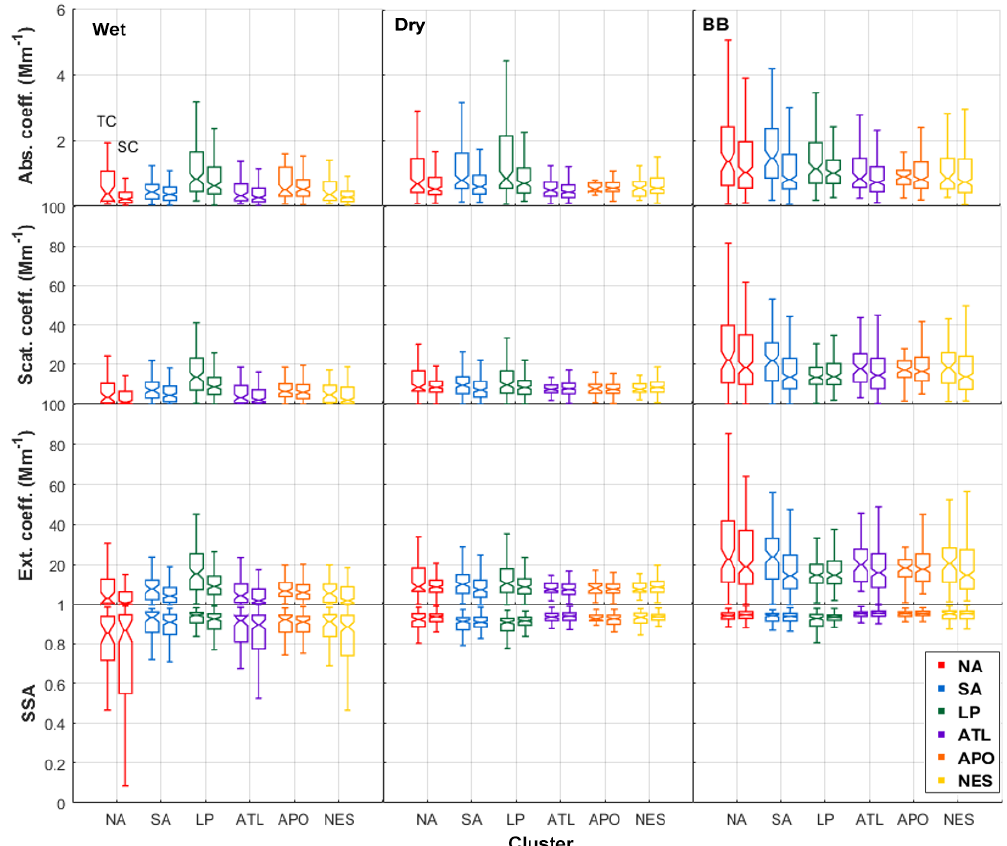
Figure 8. Aerosol particle optical properties from Chacaltaya measurements from 2012 to 2015 at 500nm for TC (left bar of each colour) and SC (right bar of each colour) layers for each cluster and the three periods.